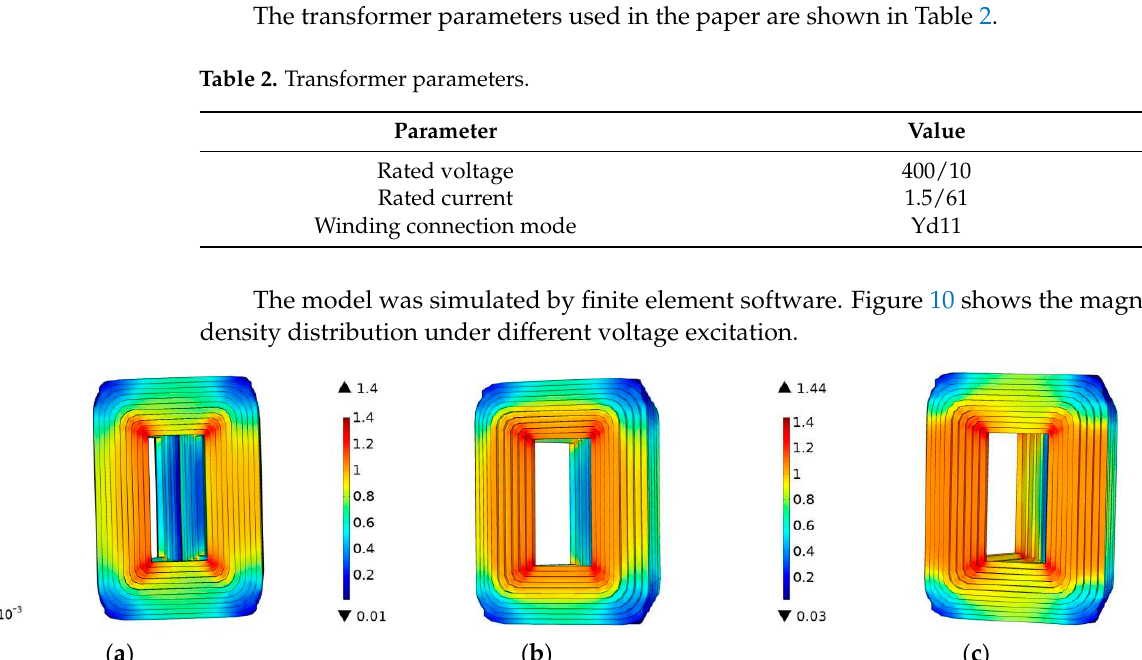
Figure 9. Wiring diagram without zero sequence path. The transformer parameters used in the paper are shown in Table 2.